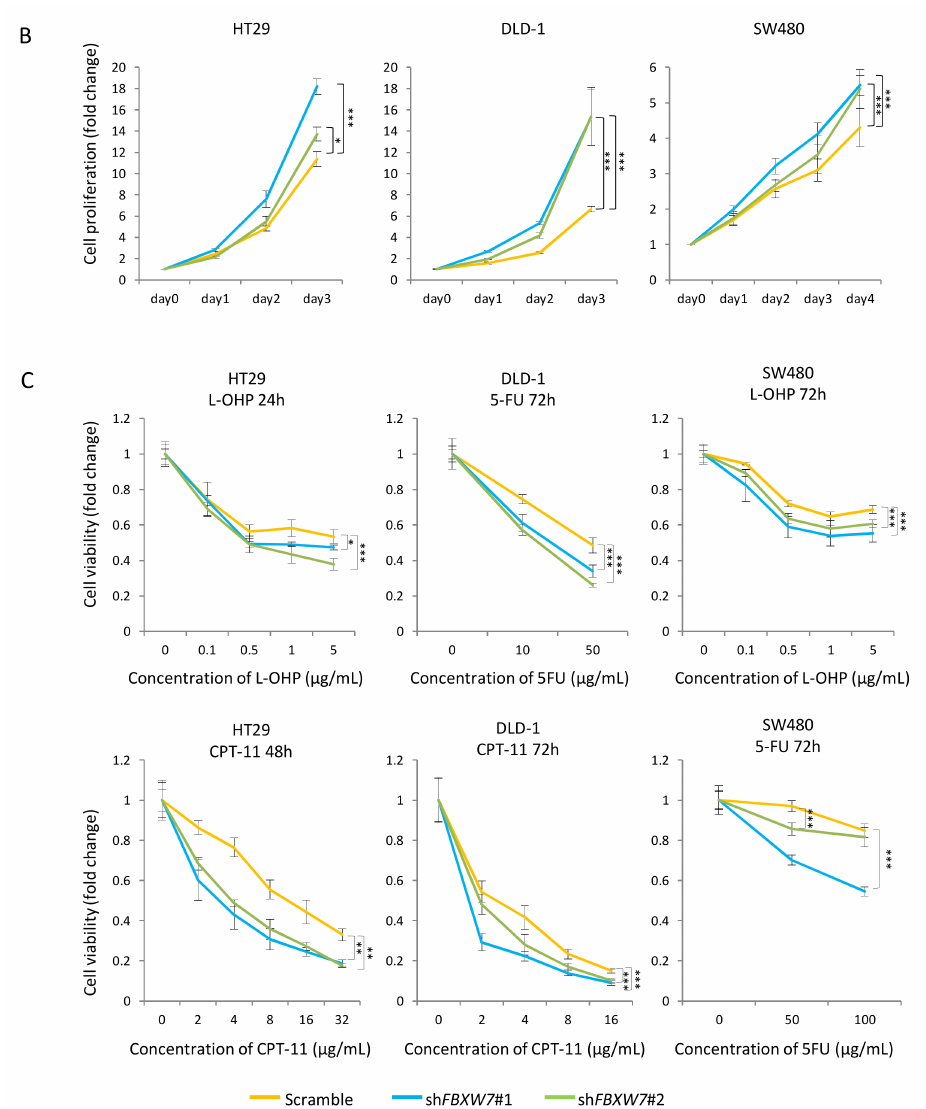
Figure 4. FBXW7 knockdown accelerates cell cycle and cell proliferation and increases sensitivity to anti-cancer drugs in CRC cell lines. ( A ) Cell cycle distributions in control and FBXW7 -silenced cells following release from cell synchronization by double thymidine block. Upper and lower panels for each CRC cell line show cell cycle distribution at 0 and 24 h after release from double thymidine synchronization. Bar graphs indicate the percentage of cells in G0 / G1, S or G2 / M phase 24 h after release from cell synchronization. ( B ) Luminescence-based cell proliferation assays in luciferase-expressing CRC cell lines in which FBXW7 was stably knocked down. ( C ) Luminescence-based cytotoxicity assays in luciferase-expressing CRC cell lines in which FBXW7 was stably knocked down. Cells were incubated for 24, 48 or 72 h with the indicated concentrations of anti-cancer drugs. Cell viability was calculated as the treated / control cell ratio of photon counts. Results are presented as the means ± standard deviation of at least three independent experiments. * p < 0.05, ** p < 0.01, *** p <